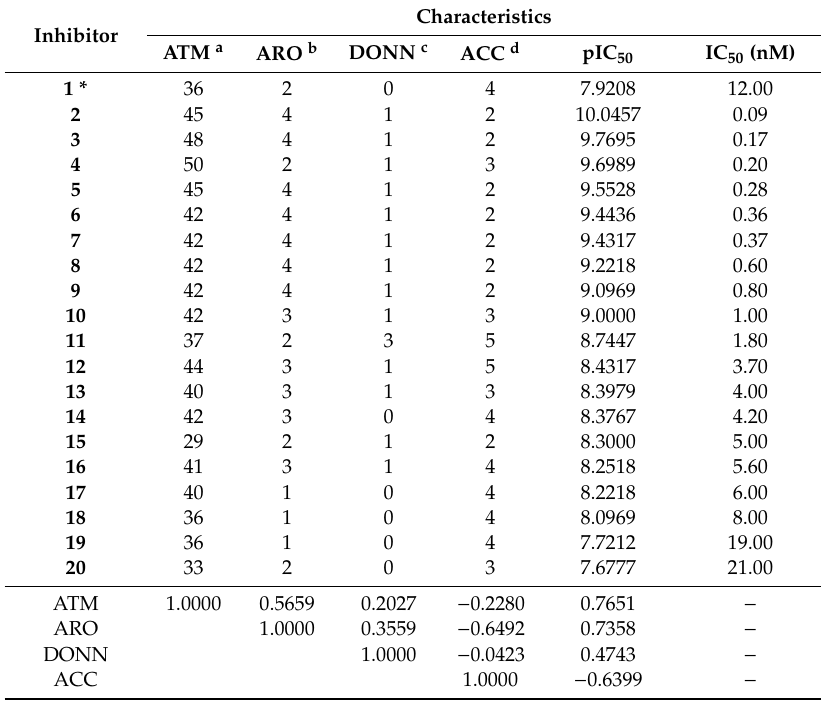
Table 1. Properties of the screened training molecules obtained from the PharmaGist